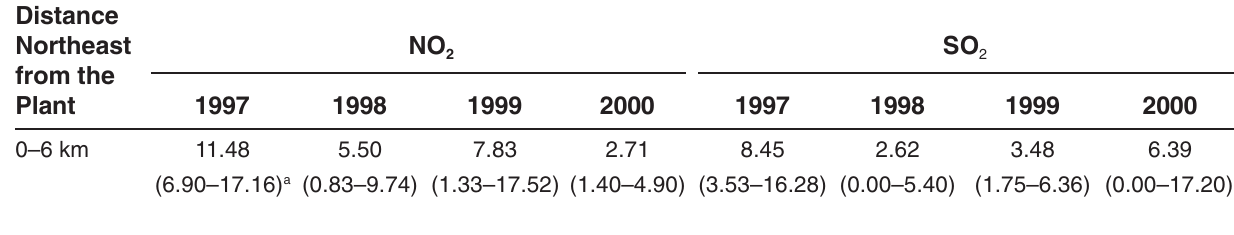
Critical annual mean levels for forest trees[17] a Minimum and maximum concentrations shown in